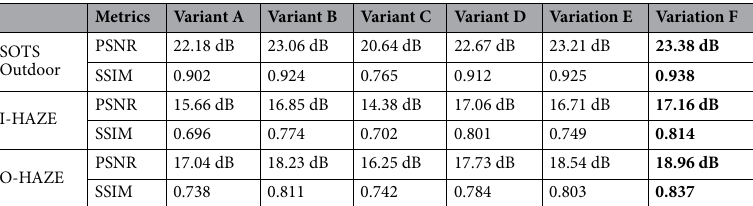
Table 4. Results of ablation study. Bold values indicate better